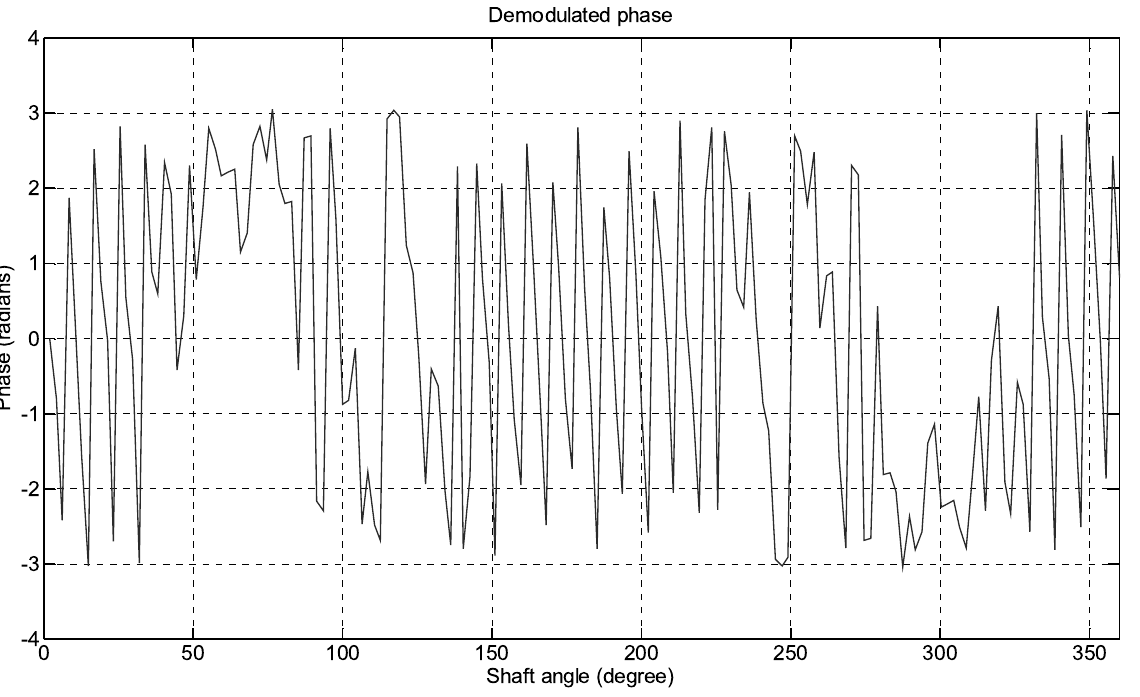
Fig. 21. Phase diagram of the residual signal of 20%